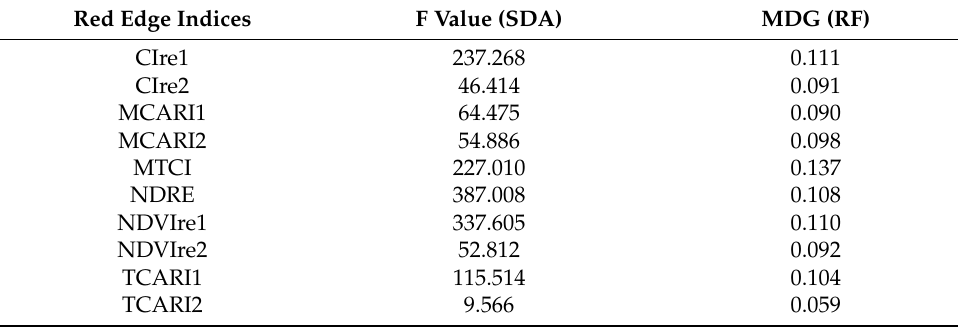
Table 6. Red edge indices importance score based on SDA and